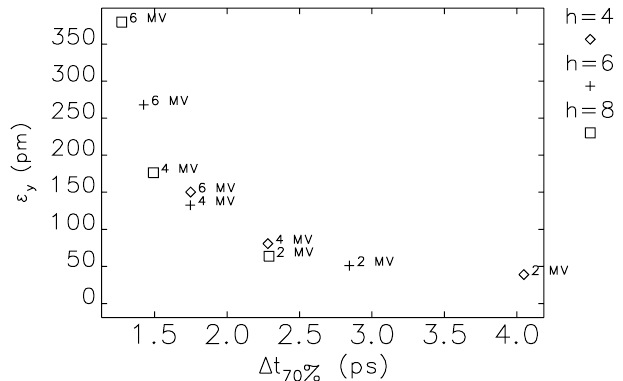
FIG. 23. (Color) Duration of the central 70% of the x-ray pulse as a function of the half-height of the slits, for various deflecting voltages and harmonic numbers of 4 and